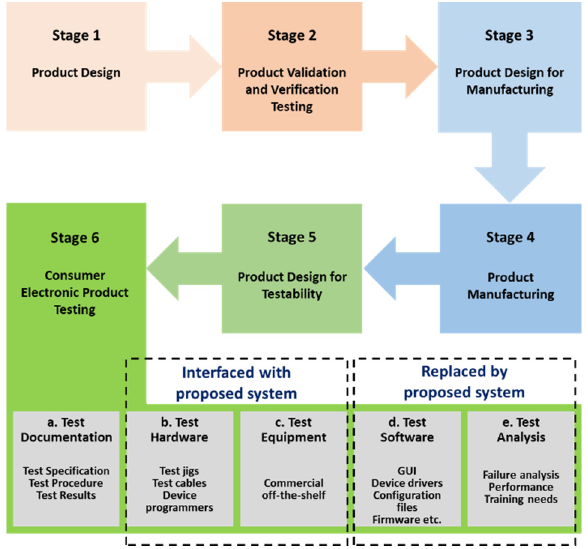
Figure 1. Consumer electronic manufacturing product lifecycle.